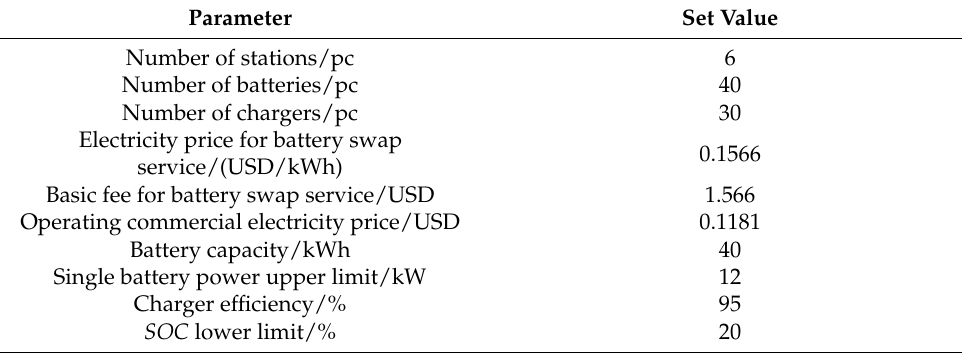
Table 2. Parameter setting of EV BSSs.